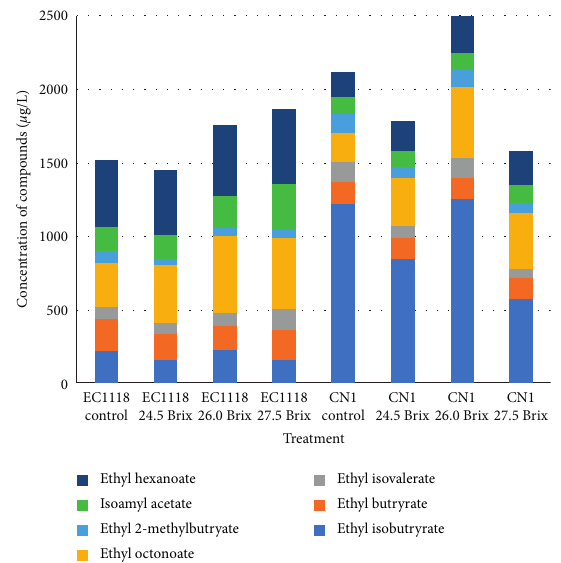
Figure 4: Concentration of selected volatile organic compounds for control (no dehydration) and wines made from partially dehydrated grapes fermented with S. cerevisiae EC1118 or S. uvarum CN1. Values are averages of 8 data points (duplicate measurements of 2 winemaking replicates, 2 bottles per